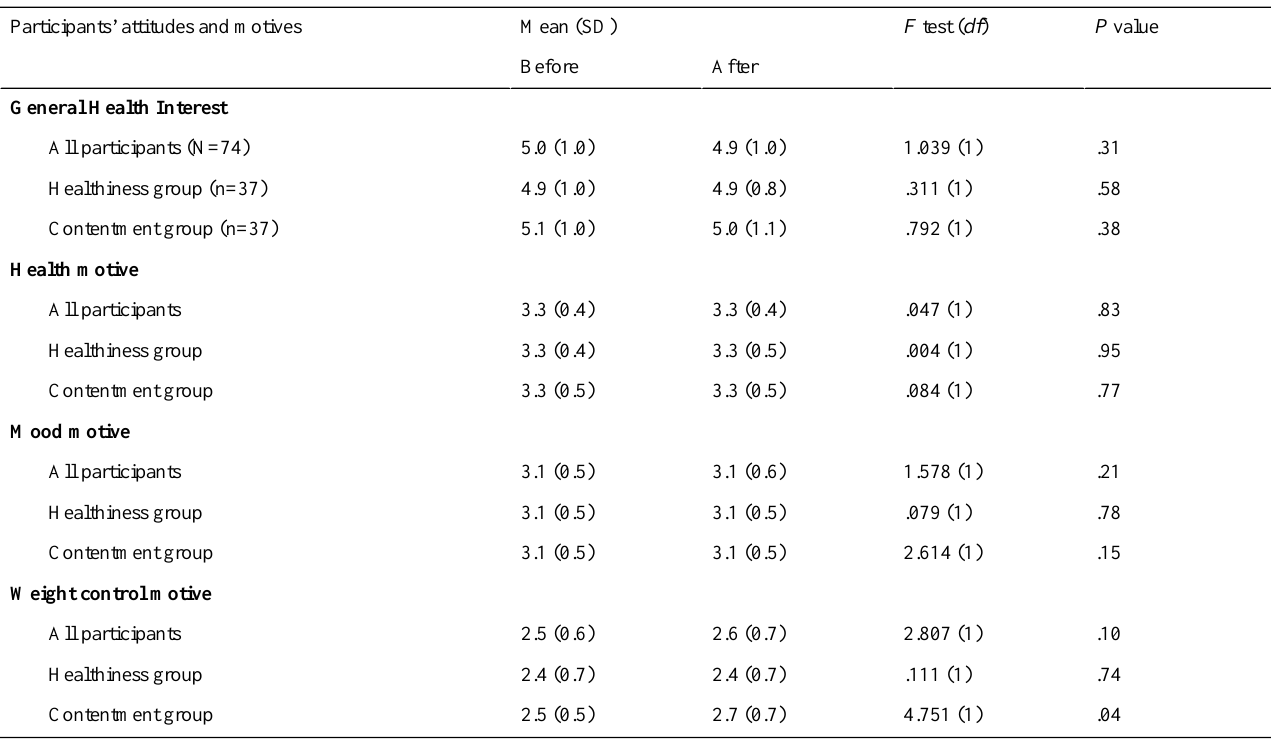
Table 7. Participants’(all participants and subgroups) attitudes toward health (General Health Interest questionnaire, scale 1-7, in which 1=completely disagree, 7=completely agree) and motives related to food choices (Food Choice questionnaire, scale 1-4, in which 1=not important at all, 4=very important; mean, SD) before the intervention and after the